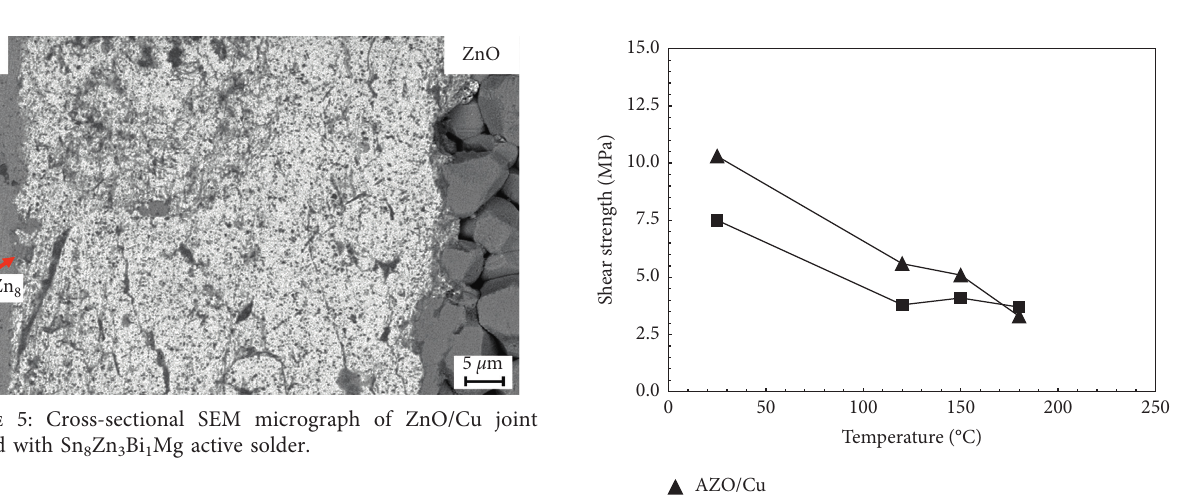
8 Zn 3 Bi 1 Mg active solder.